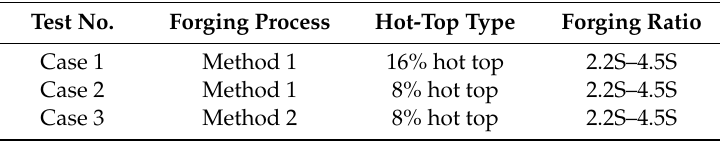
Table 4. Experimental conditions for main shaft forging.